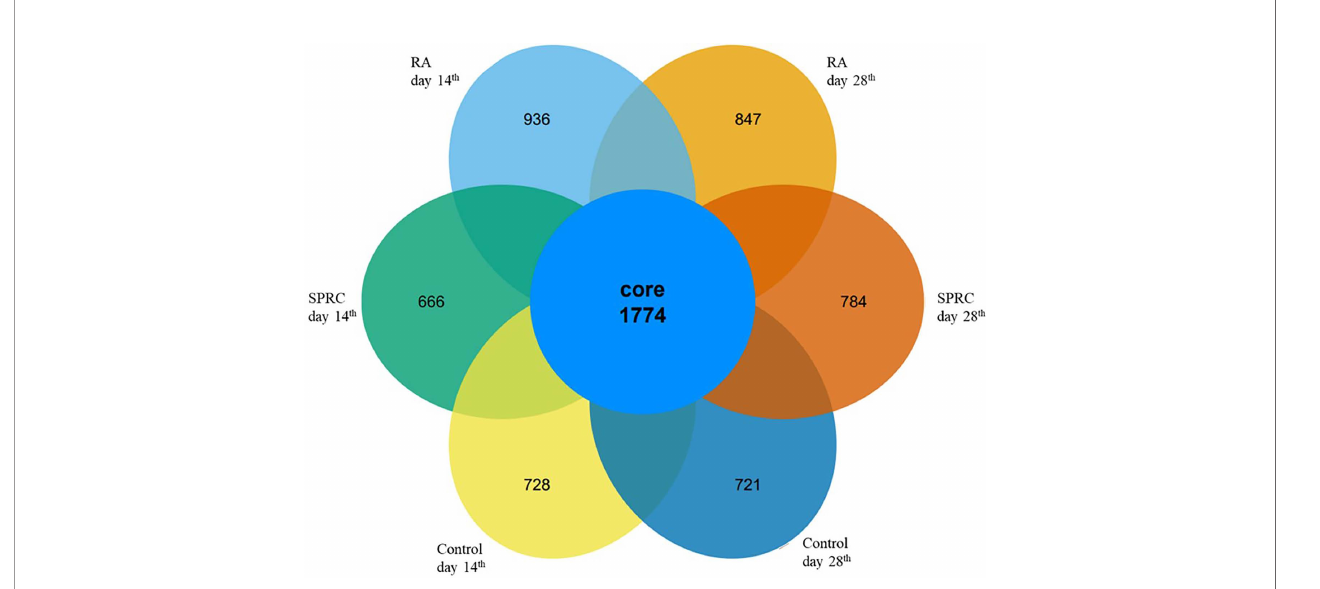
FIGURE 2 | Comparison of the OTUs between groups. The Venn diagram displays the overlaps of 1,774 core OTUs shared among groups at different time